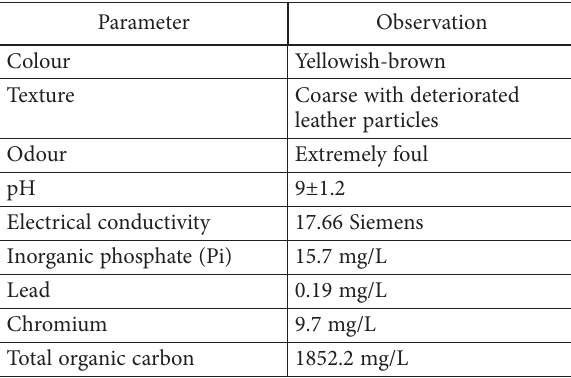
Table 1. Physicochemical parameters of the